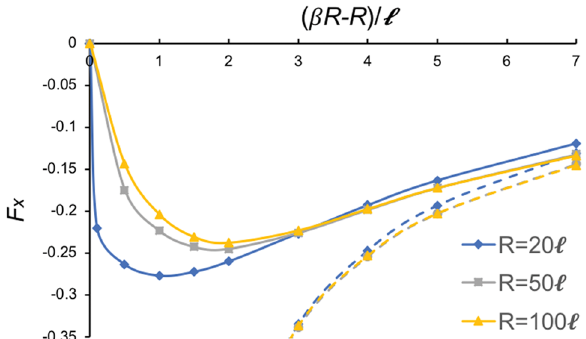
Figure 4: Dependence of the image force on the normalized distance between the dislocation and the void for different void radiuses when the Burges vector is parallel to the x -axis. The dashed curves correspond to the classical